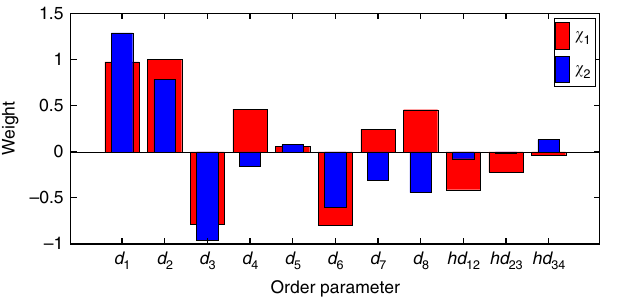
Fig. 4 The two-component predictive information bottleneck for benzene – lysozyme dissociation, where colors red and blue correspond to χ 1 and χ 2 , respectively. The optimized weights for different order parameters are illustrated after scaling all weights to keep c 1 = 1 in χ